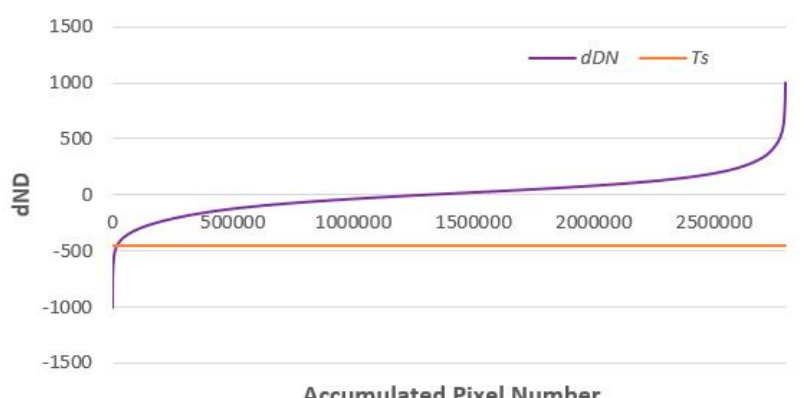
Figure 3. A typical sorted dDN cs and its accumulative pixel number distribution of a cloud contaminated image.